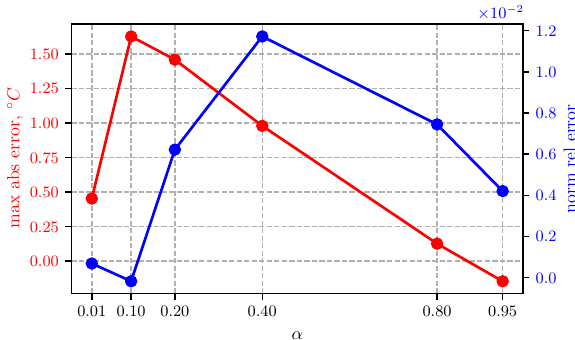
Figure 5. Evolution of maximum absolute (red) and normalized relative (blue) errors for varying infrared emissivity of CubeSat surfaces 6, 9, and